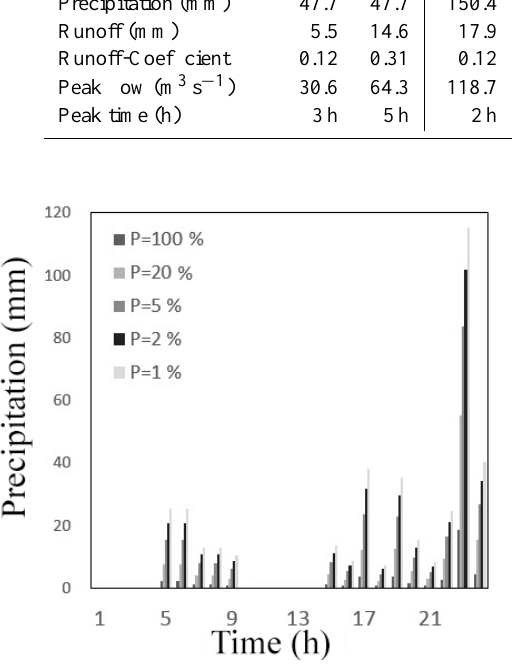
Figure 6. 24-h rainfall processes at different frequency.